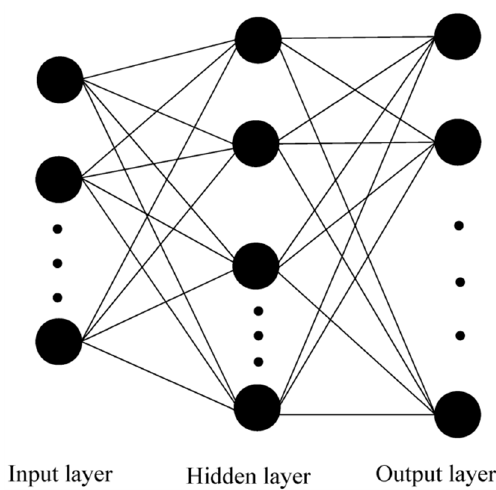
Figure 1. Typical structure of an Artificial Neural Network composed of three layers.